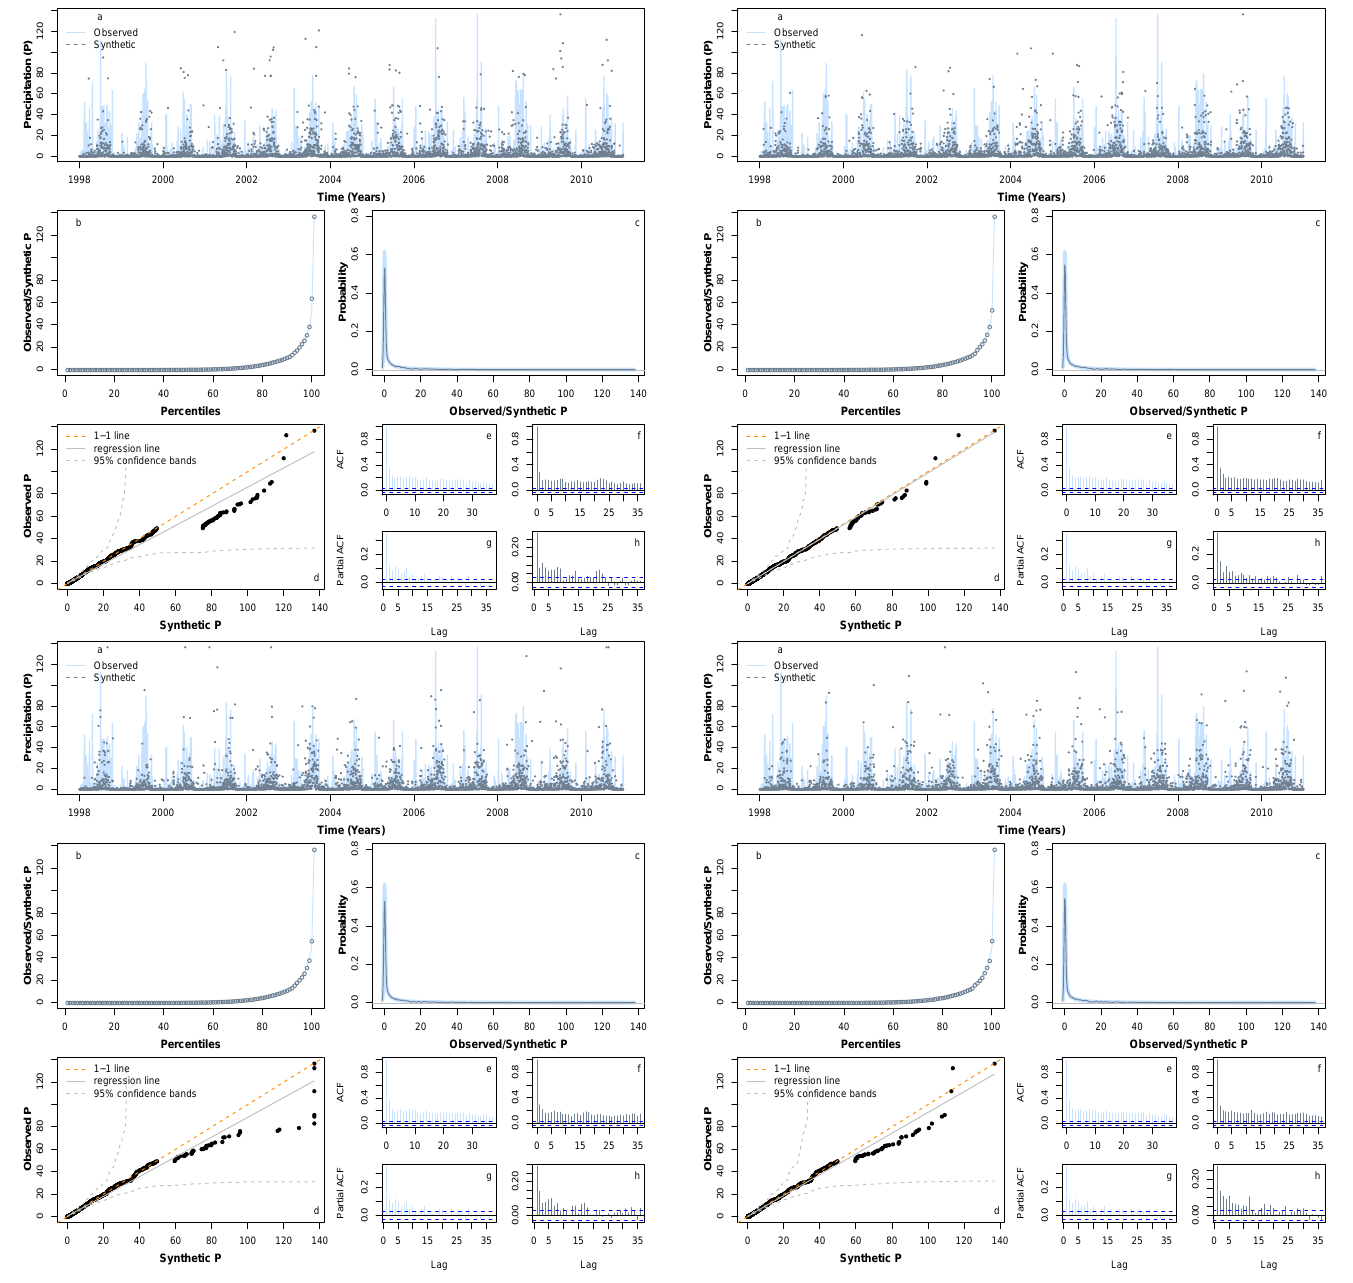
Figure A2. Comparison of four sample synthetic P time series during the period 1998–2010. This figure is aimed to illustrate the performance of the model for additional four samples and is a cluster of four subfigures that contains 8 subsubfigure each (listed as a – h ) for consistency. See Figure 7 for individual figure